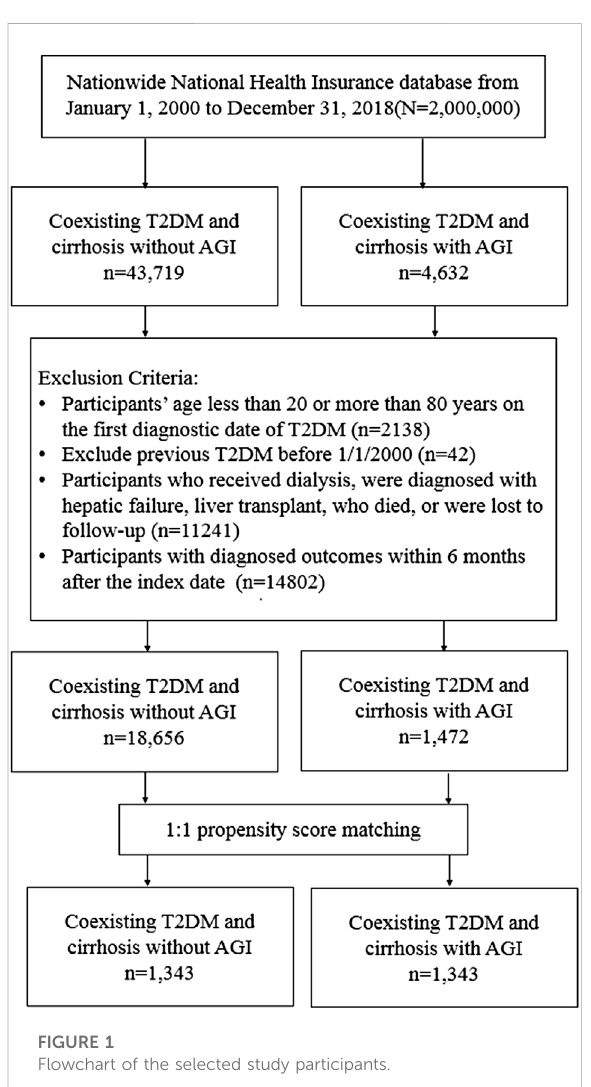
FIGURE 1 Flowchart of the selected study